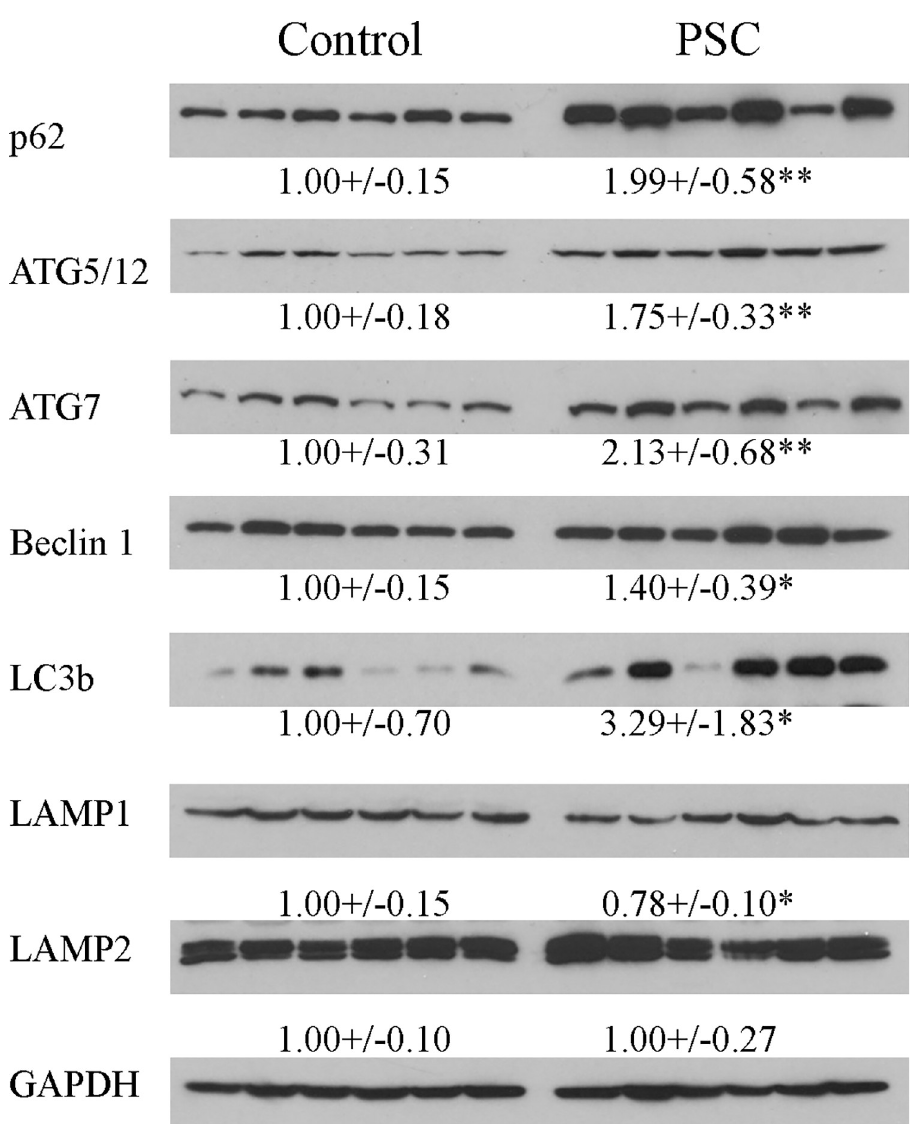
Fig 1. Increased expression of autophagic proteins in PSC. Western blotting of p62, ATG5/12, ATG7, Beclin1, LC3B, LAMP1 and LAMP2 in liver extracts prepared from patients with PSC and Controls. Blots were normalized to GAPDH expression. Data are presented as Mean ± STDEV and were statistically analyzed using Student’s t-test, � p < 0.05, �� p < 0.01, (N =